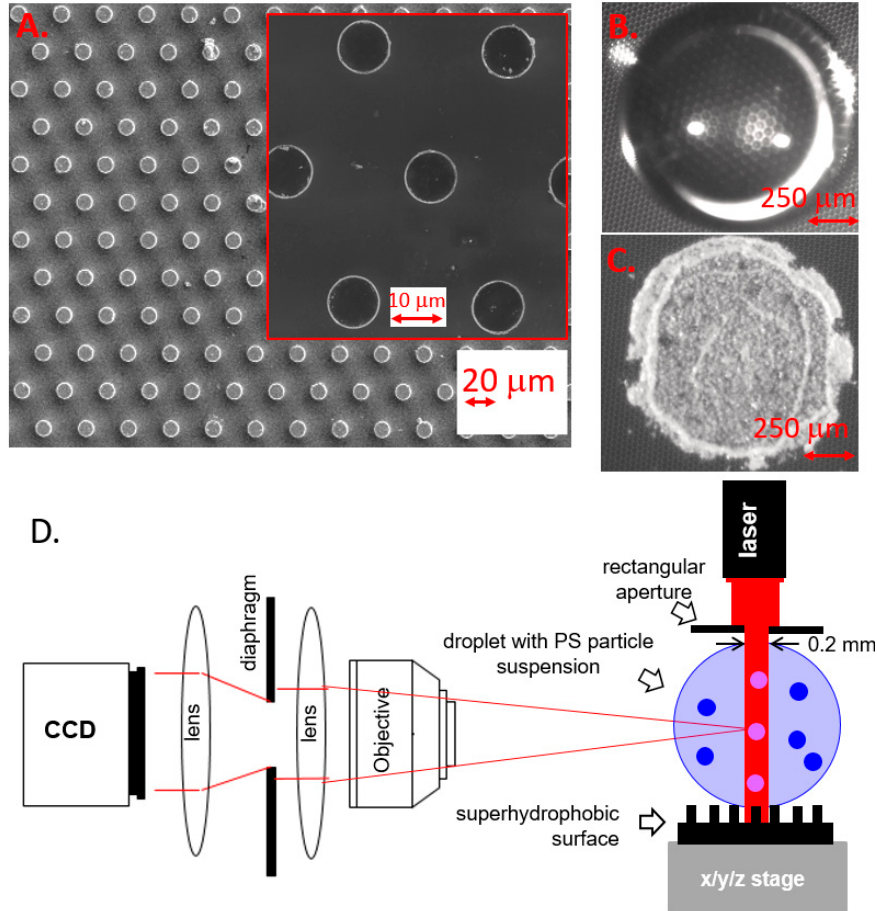
Figure 1. Scanning Eelectron Micrograph image of the pillared surface and zoom in an onset ( A ). Top view optical image of the drying droplet on the Superhydrophobic SurfaceS ( B ). Residue of polystyrene particles after evaporation ( C ). Particle image velocimetry (PIV) setup and speckle imaging. The x/y/z stage allows positioning the droplet relative to the sheet-like 0.2 × 5.6 mm 2 laser beam ( D ).